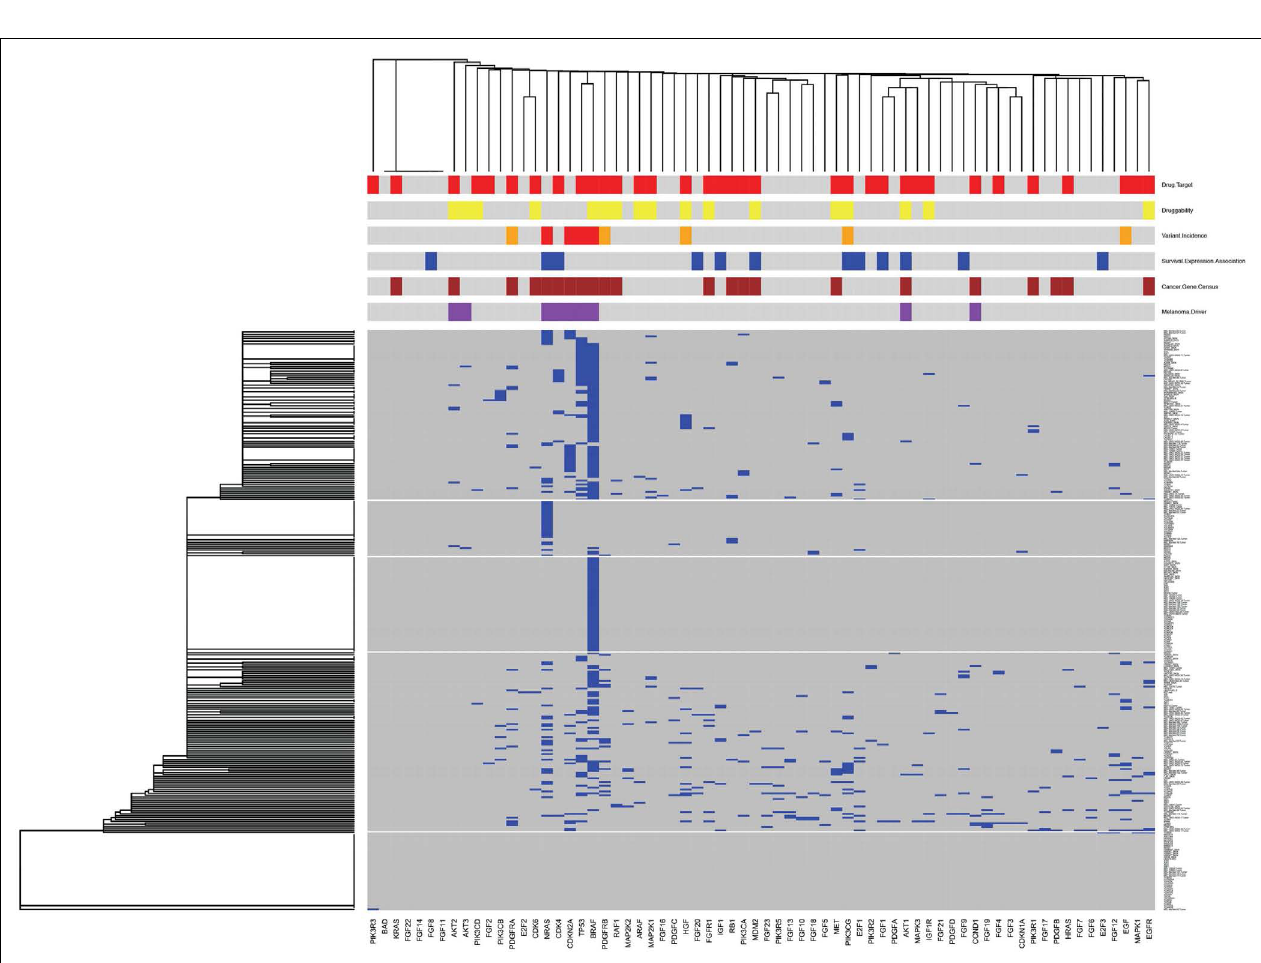
the third orange and red blocks indicate genes mutated in ≥ 1 or ≥ 5% of the 310 melanomas in our database, respectively. In the fourth row blue blocks mark genes that encode RNAs with a significant association between expression and patient survival [ p ≤ 0.05 no multiple testing correction applied, Cox proportion hazards model, Bogunovic et al. (50) data]. In the fifth row brown blocks indicate genes that are members of the WellcomeTrust Cosmic “Cancer Gene Census” gene set, as on 1st March 2013 (http://cancer.sanger.ac.uk/cancergenome/projects/census/). In the sixth row, purple blocks mark genes thought to be melanoma drivers when mutated [MelanomaDB gene set “Melanomagenesis Drivers” (84)].This graph was generated using a modification of the heatmap.2 function of the gplots package in